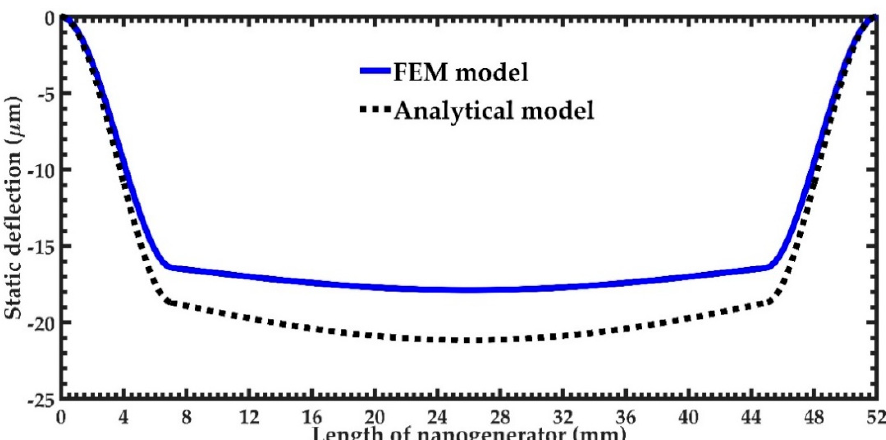
Figure 9. Static deflection of the piezoelectric nanogenerator obtained using the analytical and FEM models.